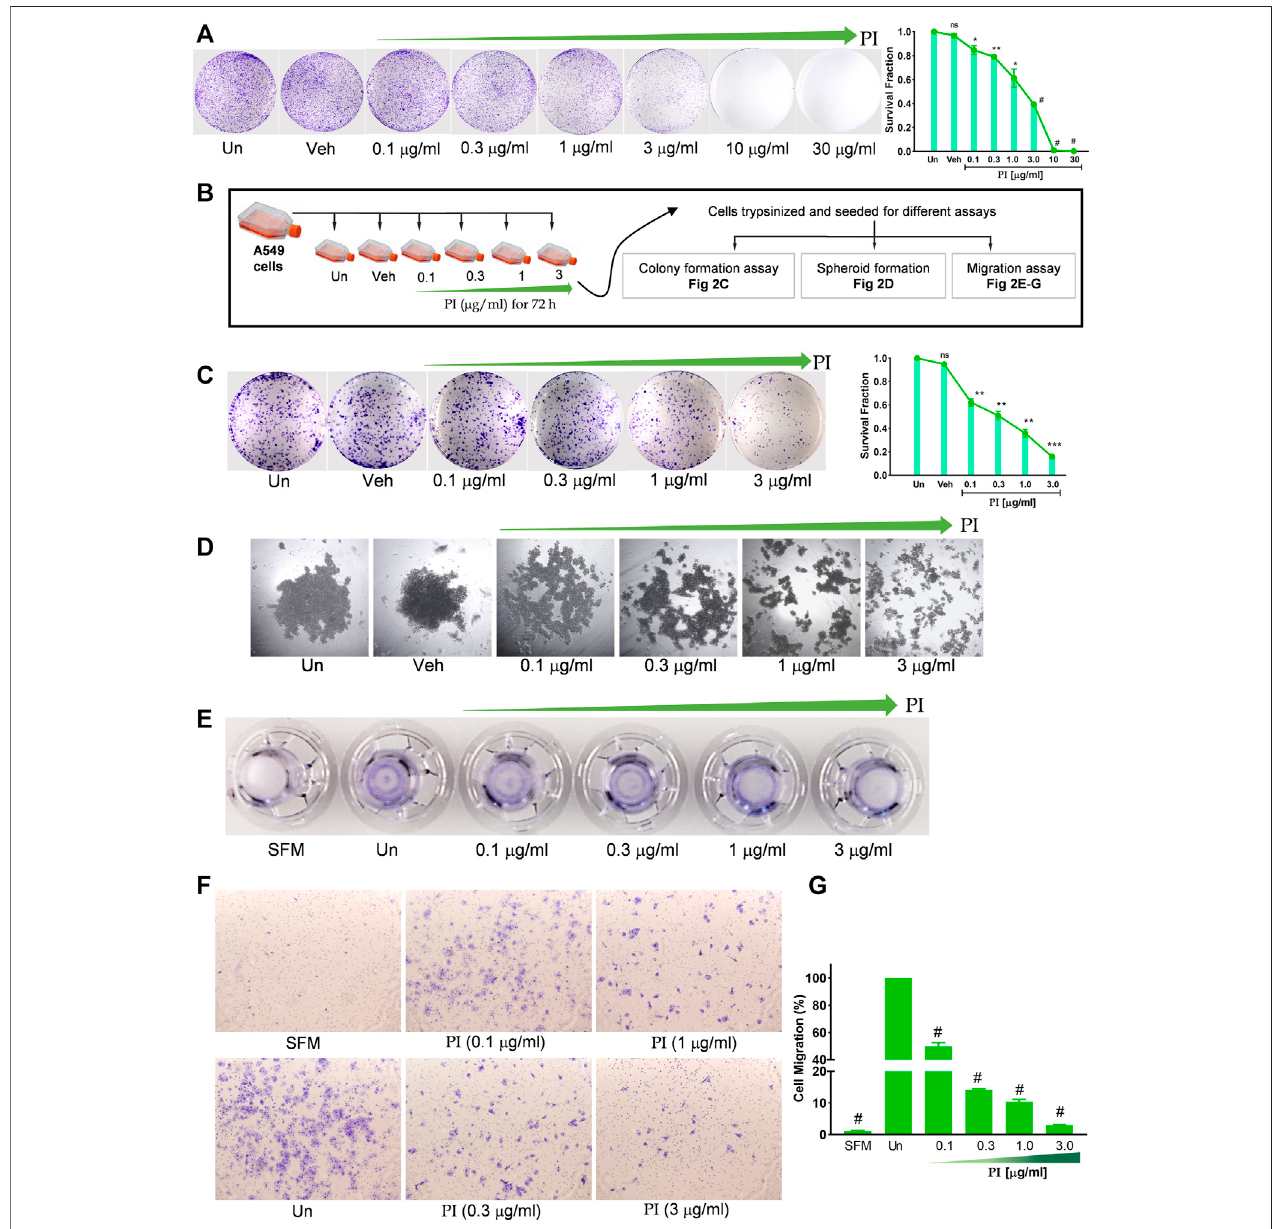
FIGURE 2 | Pistacia integerrima inhibits clonogenic and migration potential of lung cancer cells. (A) A549 cells seeded in six-well tissue culture plate at 5000 cells/ welldensity,treated with indicated PIconcentrations for72 h. Cells were stained with0.2% crystal violet and imagedusing a digital camera. Colonies were counted and expressed in survivalfraction (right panel) ( n = 3). (B) Illustration depicting experimental approachfollowed in (C – G) . (C) A549 cells seeded at 1000cells per well in asix- welltissuecultureplate,allowedtogrowfor10 daysundercellcultureconditionswithmediareplacementeverythirdday.Cellswerestainedwith0.2%crystalviolet andimagedusingadigitalcamera.Colonieswerecountedtocalculatesurvivalfraction( n =3). (D) Spheroid-likestructureswereallowedtogrowwithA549cellsthrough thehangingdropmethodfor72 h.Structureswereimagedunderaninvertedmicroscope. (E) Imagesofthetranswellinserts(inverted)capturedusingthedigitalcamera show the comparative intensity ofcrystal violet indicating migration ofA549 cells. (F) Representative images captured under the microscope showing the migrated cells intrans-well. (G) NumberofcellsmigratedinresponsetoPItreatmentwerecountedandgraphicallyrepresented.Percentageofmigratedcellswascountedwithrespect to untreated. One-way ANOVA was used to analyze signi fi cant differences with respect to untreated conditions. Error bars represent mean ± SEM; signi fi cance of data represented as * p < 0.05, ** p < 0.005, *** p < 0.0005, # p < 0.0001 and not signi fi cant (ns) if p > 0.05.